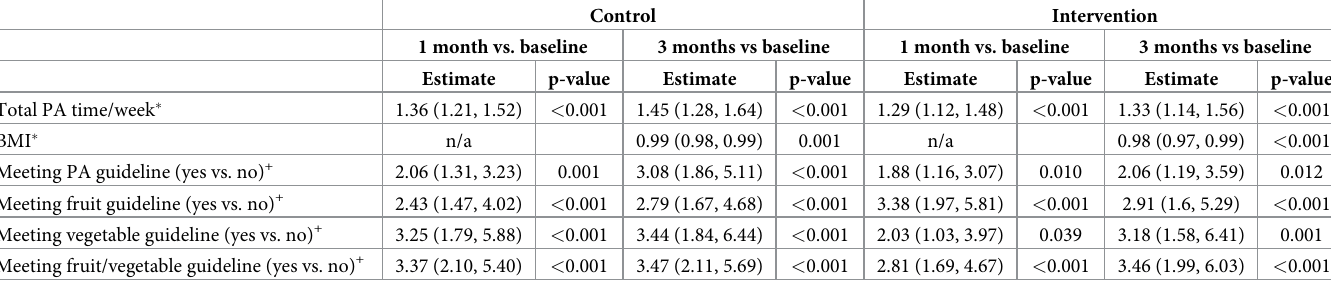
Table 4. Time effect for Body Mass Index, physical activity and fruit and vegetable intakes, by group.